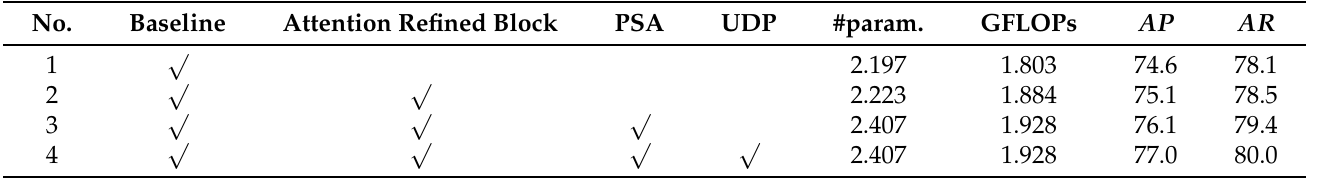
Table 5. Influence of selecting the attention-refined block and polarized self-attention. We show #param, GFLOPs, AP, and AR on the macaque monkey test